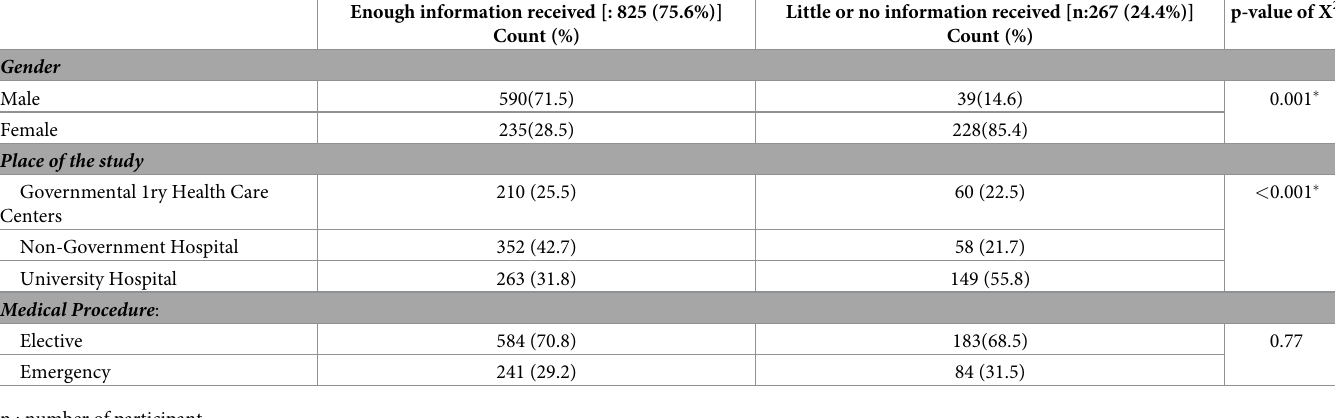
Table 2. Factors influencing participants’ perception of the amount of information received during the informed consent